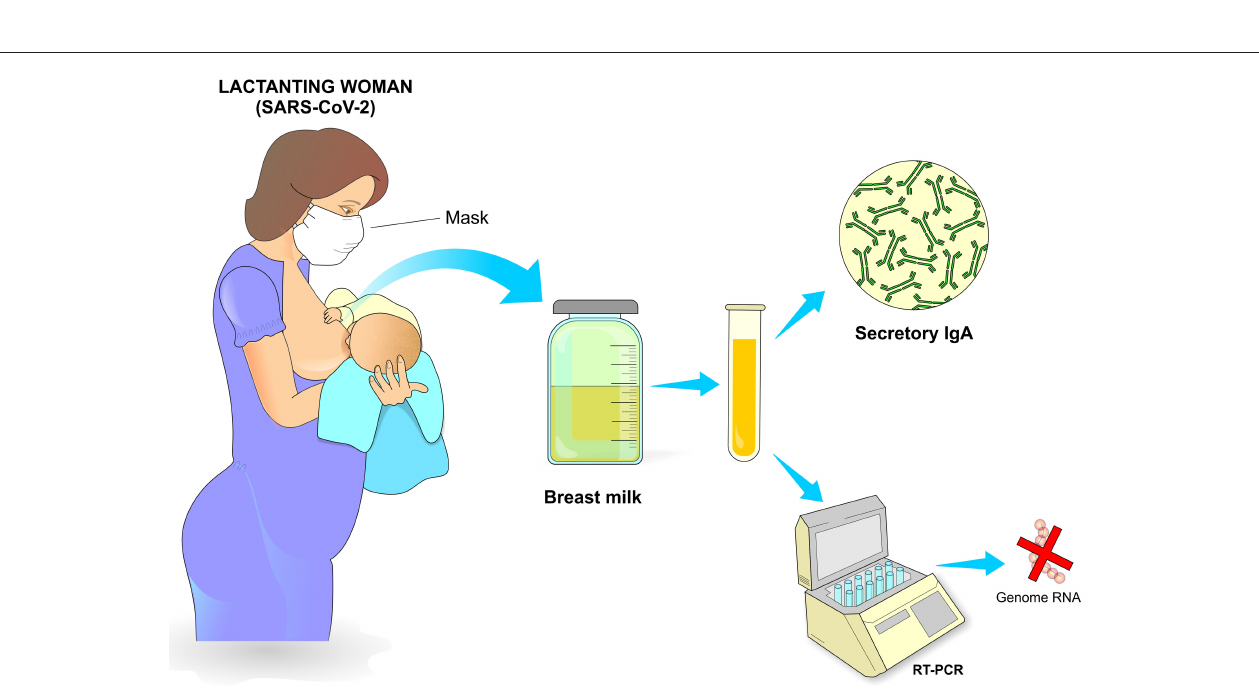
FIGURE 11 | Postpartum care. Breastfeeding is recommended as long as the conditions of the infected mother are appropriate, which include adequate breastfeeding procedure, use of a mask with adequate filtering, cleaning of the breasts and nipples and general care that minimizes contamination of the newborn. Milking can also be carried out, preferably with an appropriate suction pump after previous hygiene of the breasts and with subsequent adequate storage. The presence of secretory IgA in breast milk represents an important passive protection transmitted from the mother to the newborn through breastfeeding.